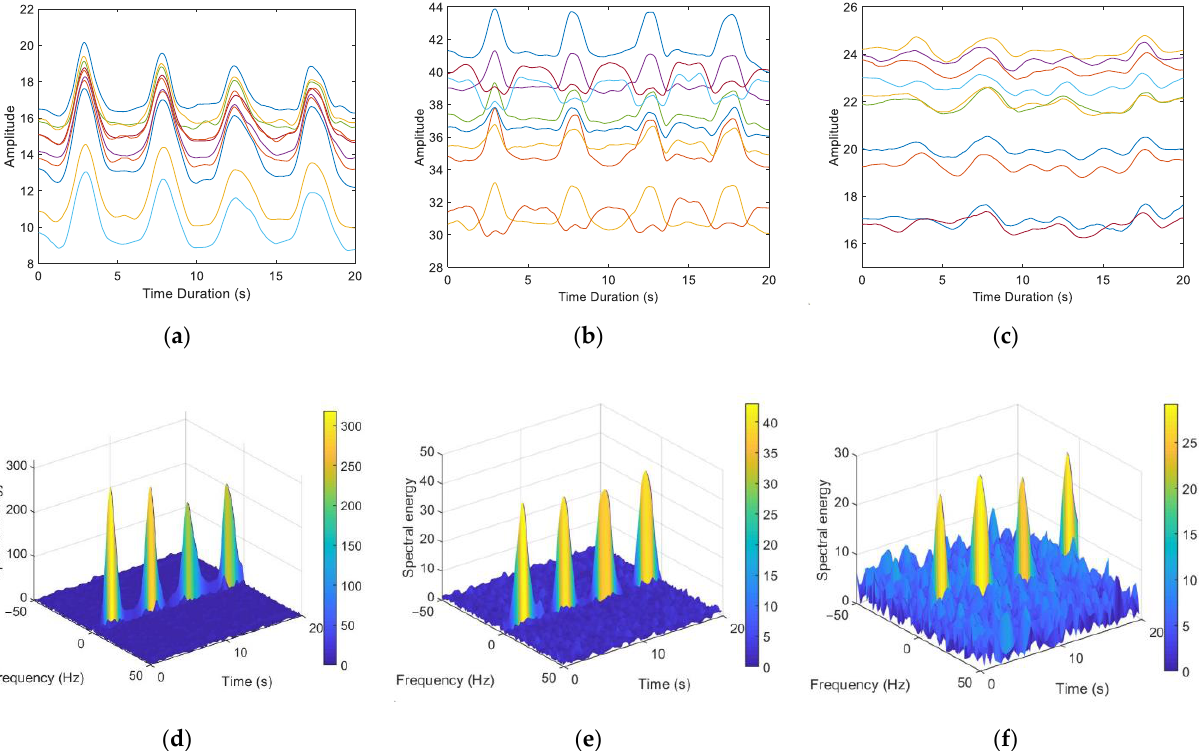
Figure 8. CSI waveforms and corresponding 3D spectrogram of respiration signal extraction results of the three breathing patterns: ( a , d ) deep breathing, ( b , e ) normal breathing and ( c , f )weak breathing.